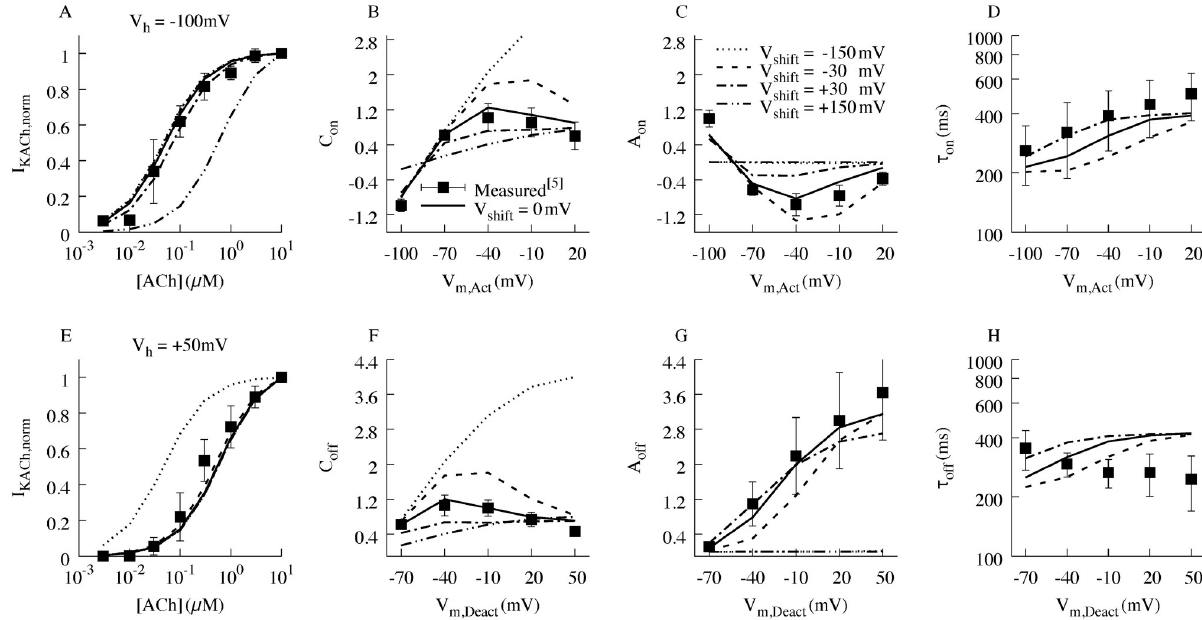
Fig 3. Concentration-response curves and relaxation gating features. Concentration-response curves at a holding potential of (A) -100 mV and (E) +50 mV. Relaxation gating features derived from the mono-exponential fitting of activation and deactivation traces (B,C,F,G). The associated relaxation kinetic time constants are shown in (D,H). Measured data is represented as mean ± std. Respectively the squared fit error for each feature is; C on : 0.06, C off : 0.025, A on : 0.11, Aoff: 0.014, τ on : 0.04, τ off : 0.18, I KACh,norm,-100mV : 0.003, I KACh,norm,50mV : 0.03. The total error of the features is equal to the square root of the sum of the respective squared fit errors (Eq 11 and Methods).